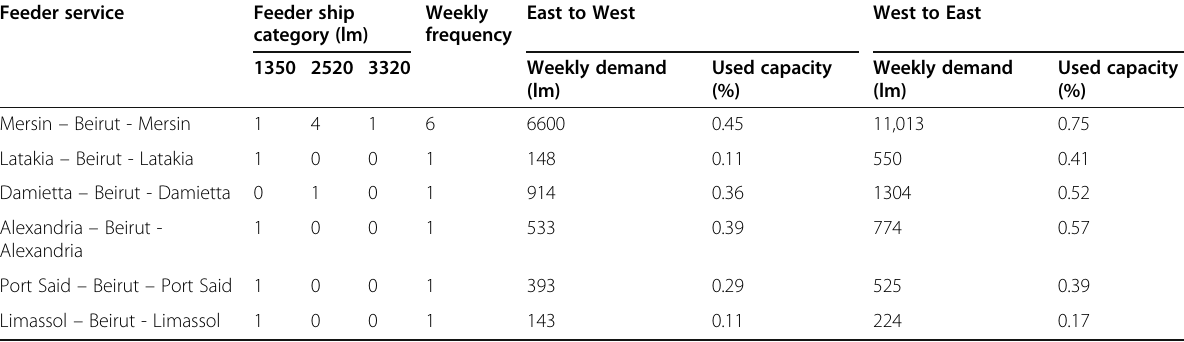
Table 22 Leg 3 - Eastern feeder services: frequencies and capacities Feeder